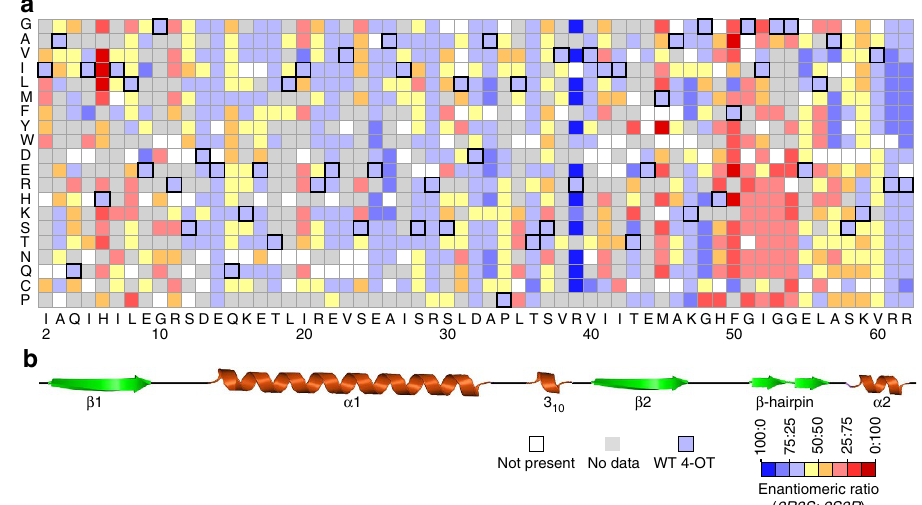
Figure 5 | Mutability landscape of 4-OT for enantioselectivity in the Michael-type addition of 4 to 5a. ( a ) The horizontal axis of the data matrix depicts the wild-type sequence of 4-OTand the vertical axis depicts the 20 possible amino acid residues. The wild-type amino acid residue at each position is indicated by bold squares and white boxes represent mutants that are not present in the collection. The colour indicates the e.r. ( 2R3S : 2S3R ) of the major syn diastereoisomer of 7 as produced by the 4-OT variants. The e.r. values were determined by HPLC on a chiral stationary phase. Grey boxes represent mutants that did not produce sufficient amounts of 7 to give an adequate ultraviolet signal during HPLC analysis. As expected, these grey boxes mainly coincide with the grey and dark blue boxes in Fig. 3c, which indicate mutants that either did not express or lack significant ‘Michaelase’ activity. ( b ) The secondary-structure elements of 4-OT 20